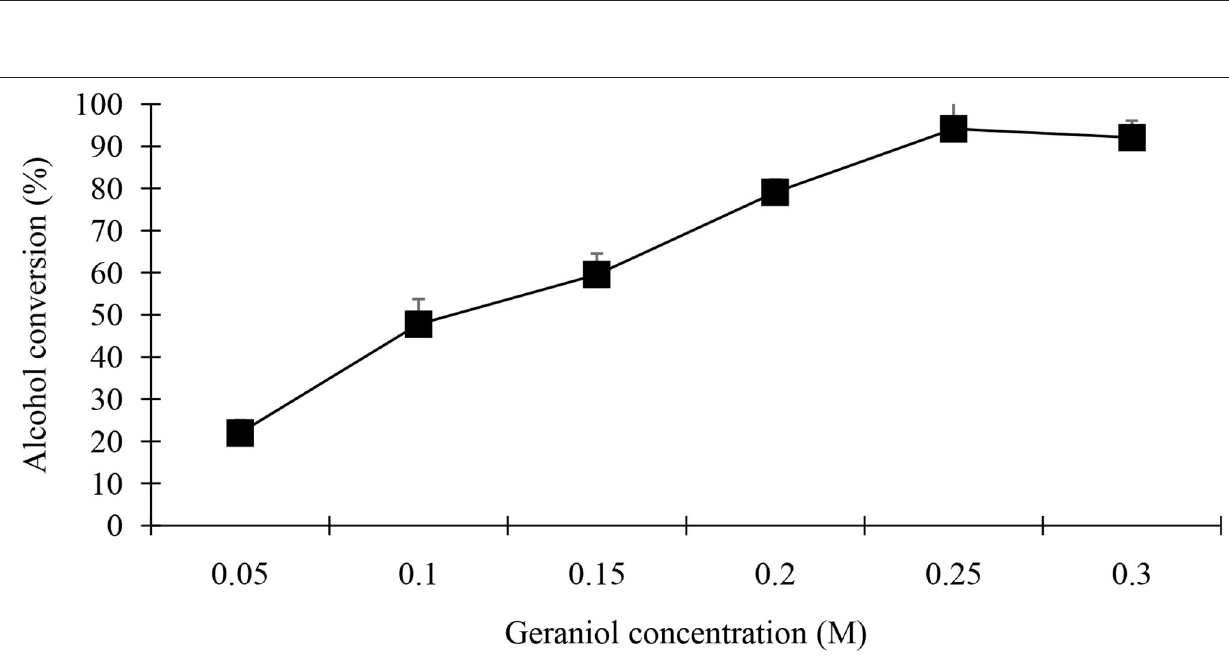
FIGURE 12 | Effect of geraniol alcohol concentration on synthesis of geranyl butyrate ester was investigated. Various concentrations of geraniol were investigated while concentration of butyric acid was kept constant at 0.25M. Reaction mixture contain 0.25g of black cumin seedling acetone powder in 5mL n -hexane. All reactions were carried out over a period of 48h at 37 ◦